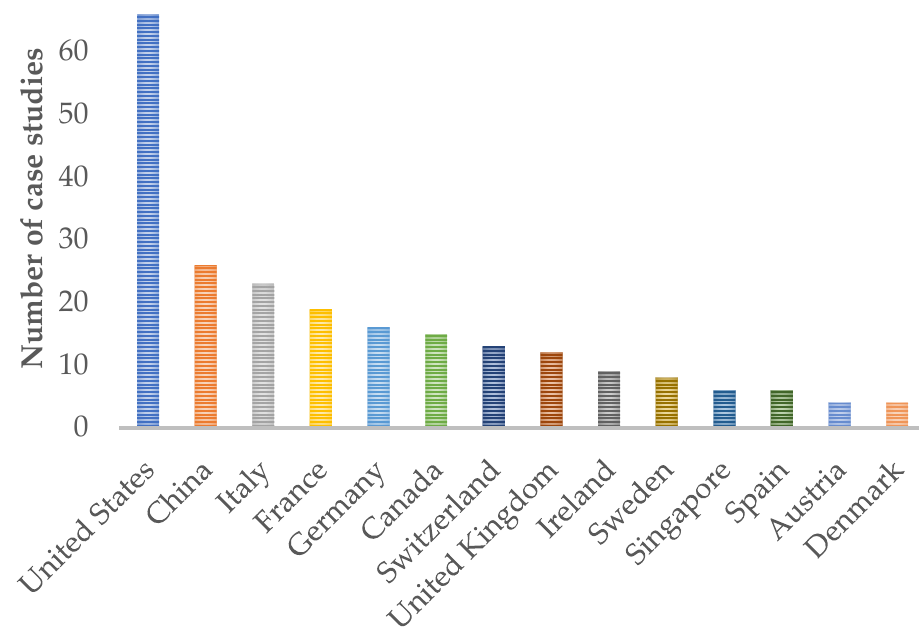
Figure 18. The number of urban building energy modeling studies in different countries.